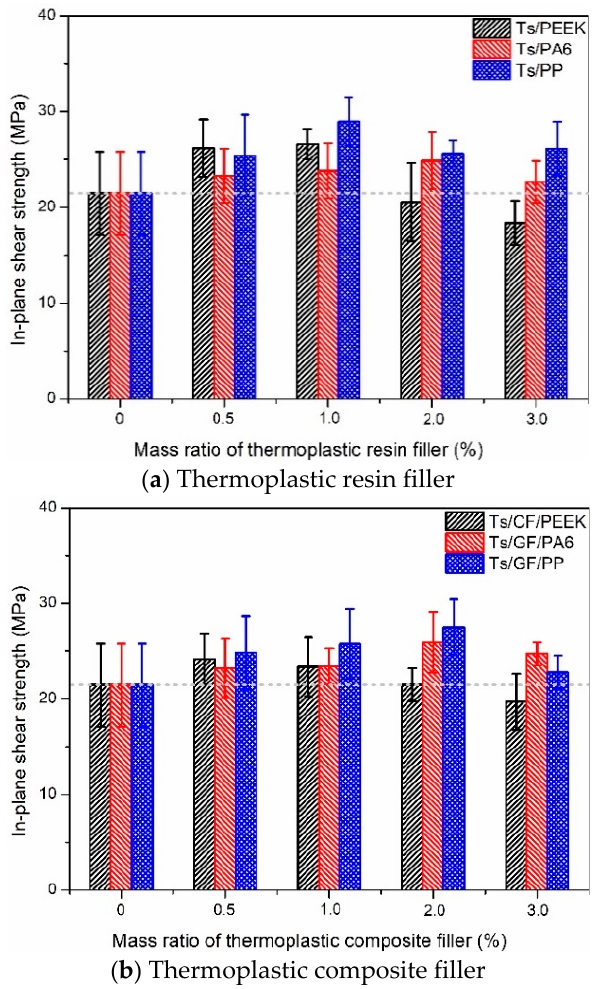
Figure 9. Effects of thermoplastic resin and composite fillers on the in-plane shear strength of Ts resin of ( a ) thermoplastic resin filler and ( b ) thermoplastic composite filler.